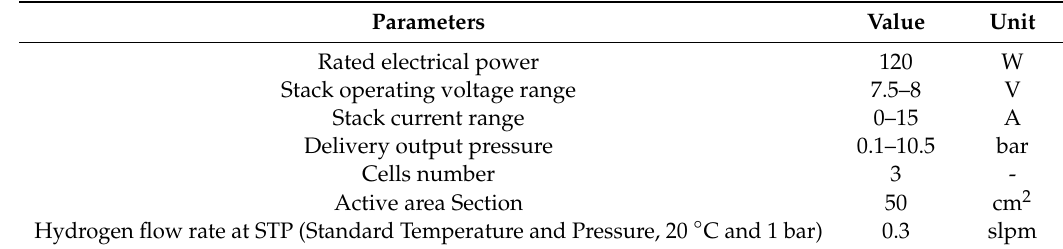
Figure 3. EL voltage, power vs current. Table 1. Main features of the investigated electrolyzer.